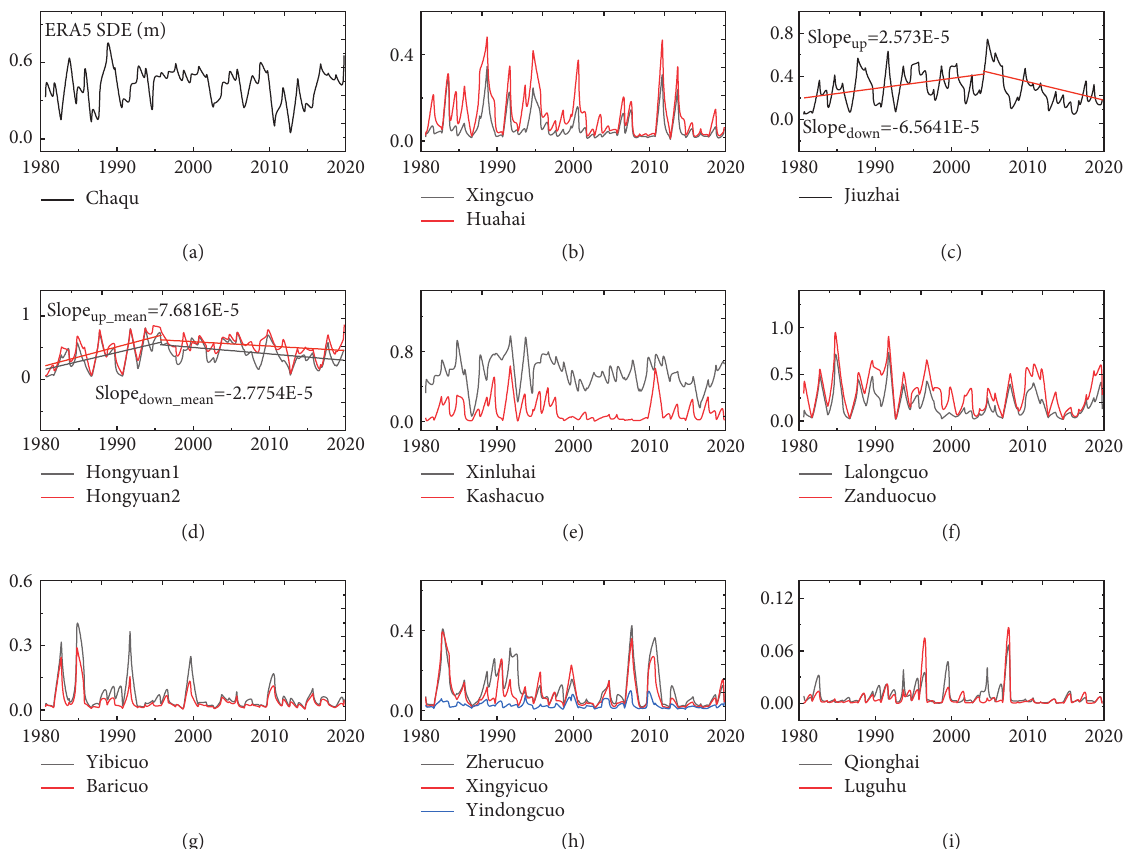
Figure 14: SDE change trend of the lake wetland on a site scale (2000–2020). Latitude of the lake site gradually decreased from subfigure (a) to (i). Elevation of sites (a), (d), (g), (f), and (h) are above 4500m elevation of sites (b), (c), and (e) are about 3000–3900m, and elevation of site (i) is less than 3000m.